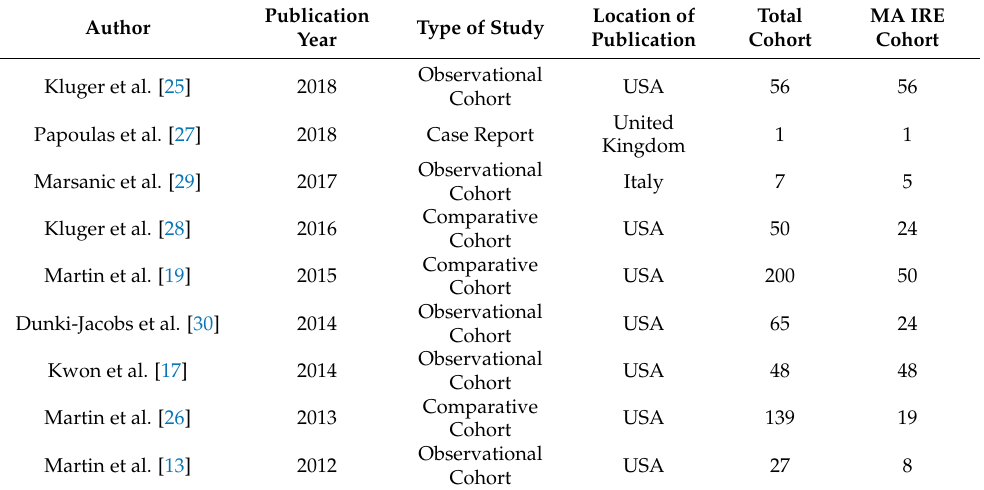
Table 2. Tumour and treatment characteristics of all included studies .